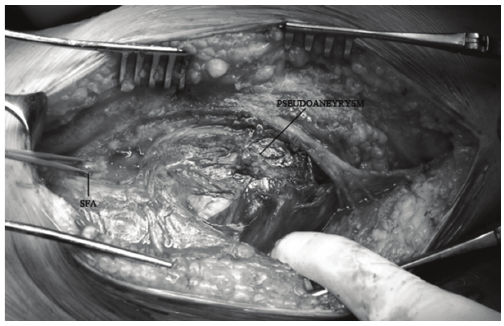
Figure 2: Severely destructed superficial femoral artery and the pseudoaneurysm ( SFA, superficial femoral artery).